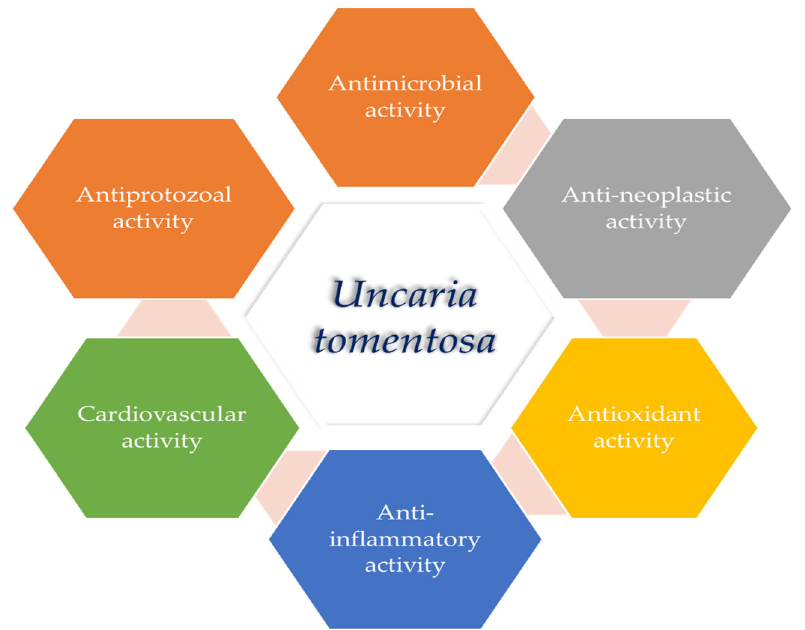
Figure 1. Schematic representation of different pharmacological activities of Uncaria tomentosa (cat’s claw).